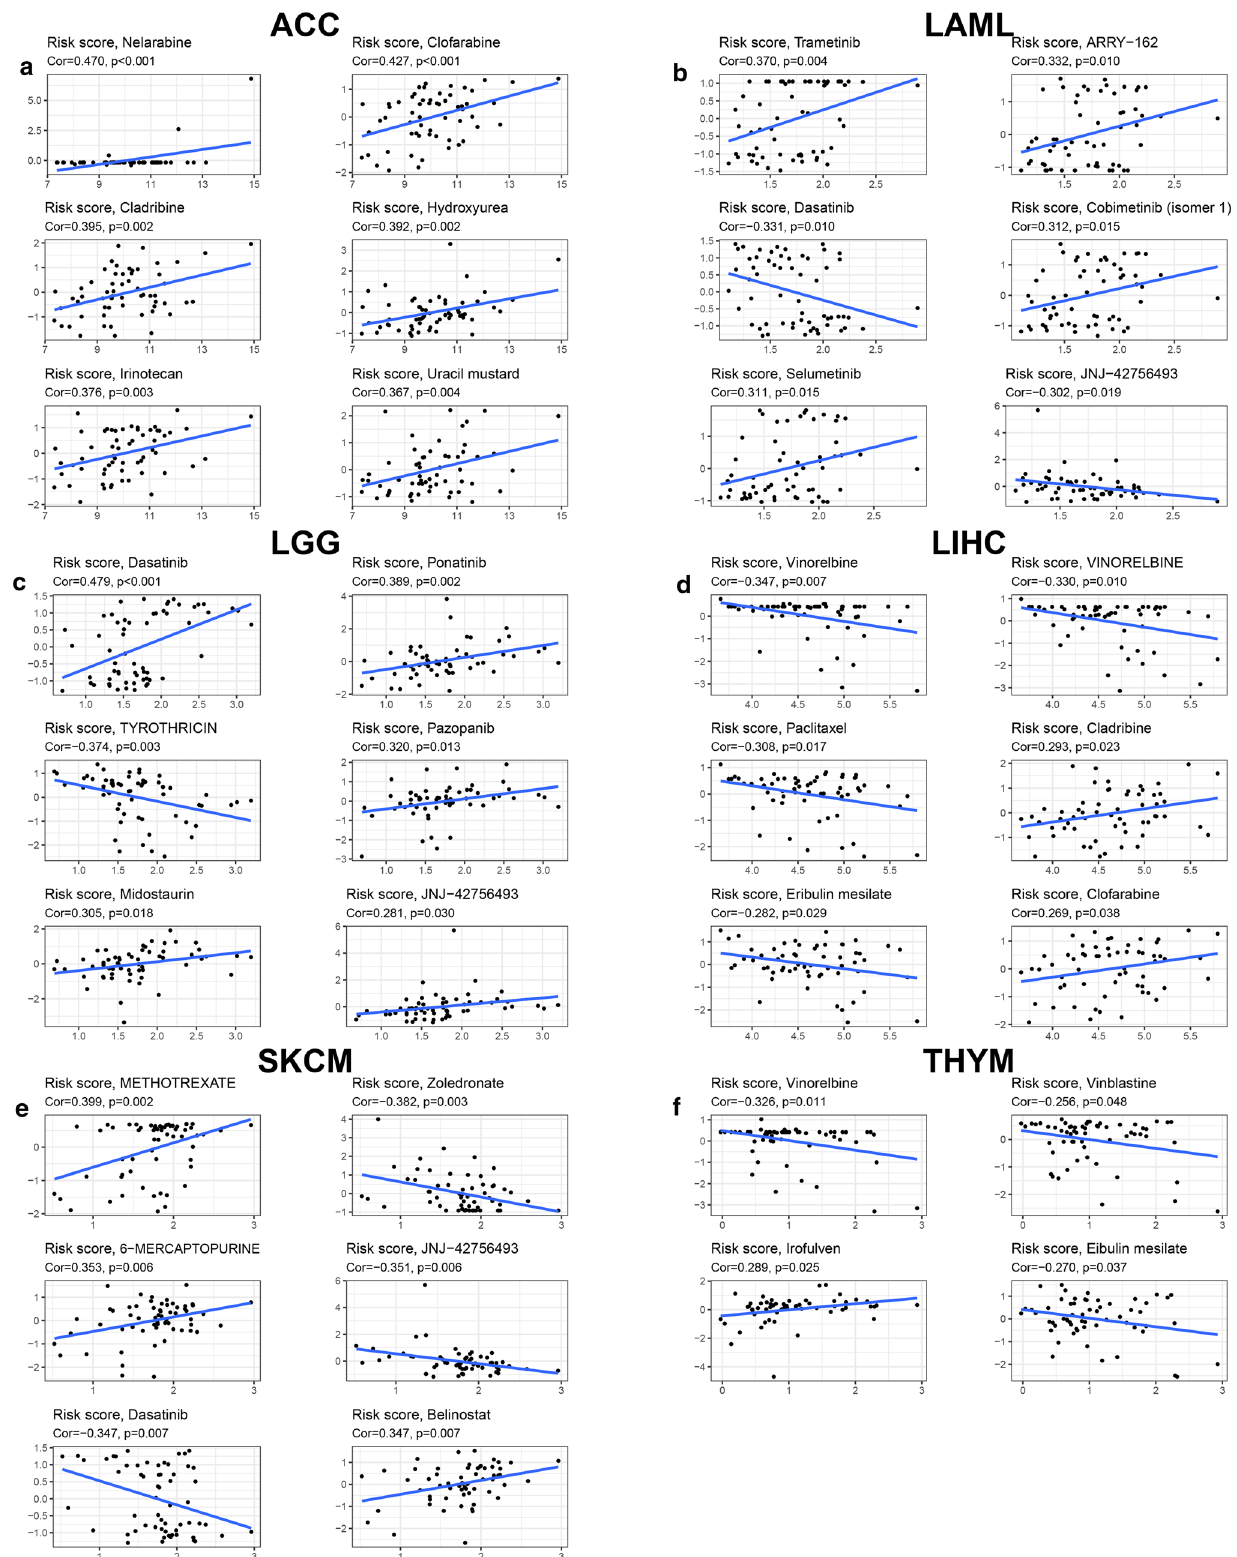
Fig. 12 Drug sensitivity exploration. We calculated the risk score of each CellMiner sample according to the genes and coefficient of the risk models of the six cancers. The scatter diagrams showed the correlation between risk score and sensitivity (z-score) of Food and Drug Administration (FDA)- approved drugs in ACC ( a ), LAML ( b ), LGG ( c ), LIHC ( d ), SKCM ( e ) and THYM ( f ), with Pearson correlation coefficient (Cor) and p value marked above the